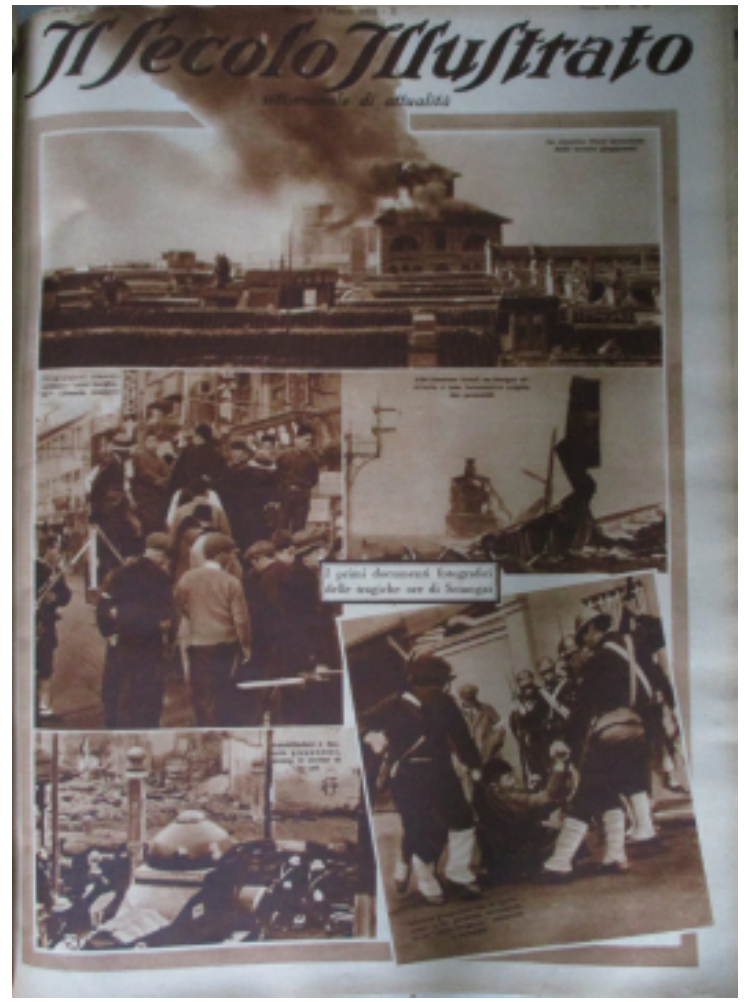
‘I primi documenti fotografici delle tragiche ore di Sciangai’, Il Secolo Illustrato , 21.10 (5 March 1932),